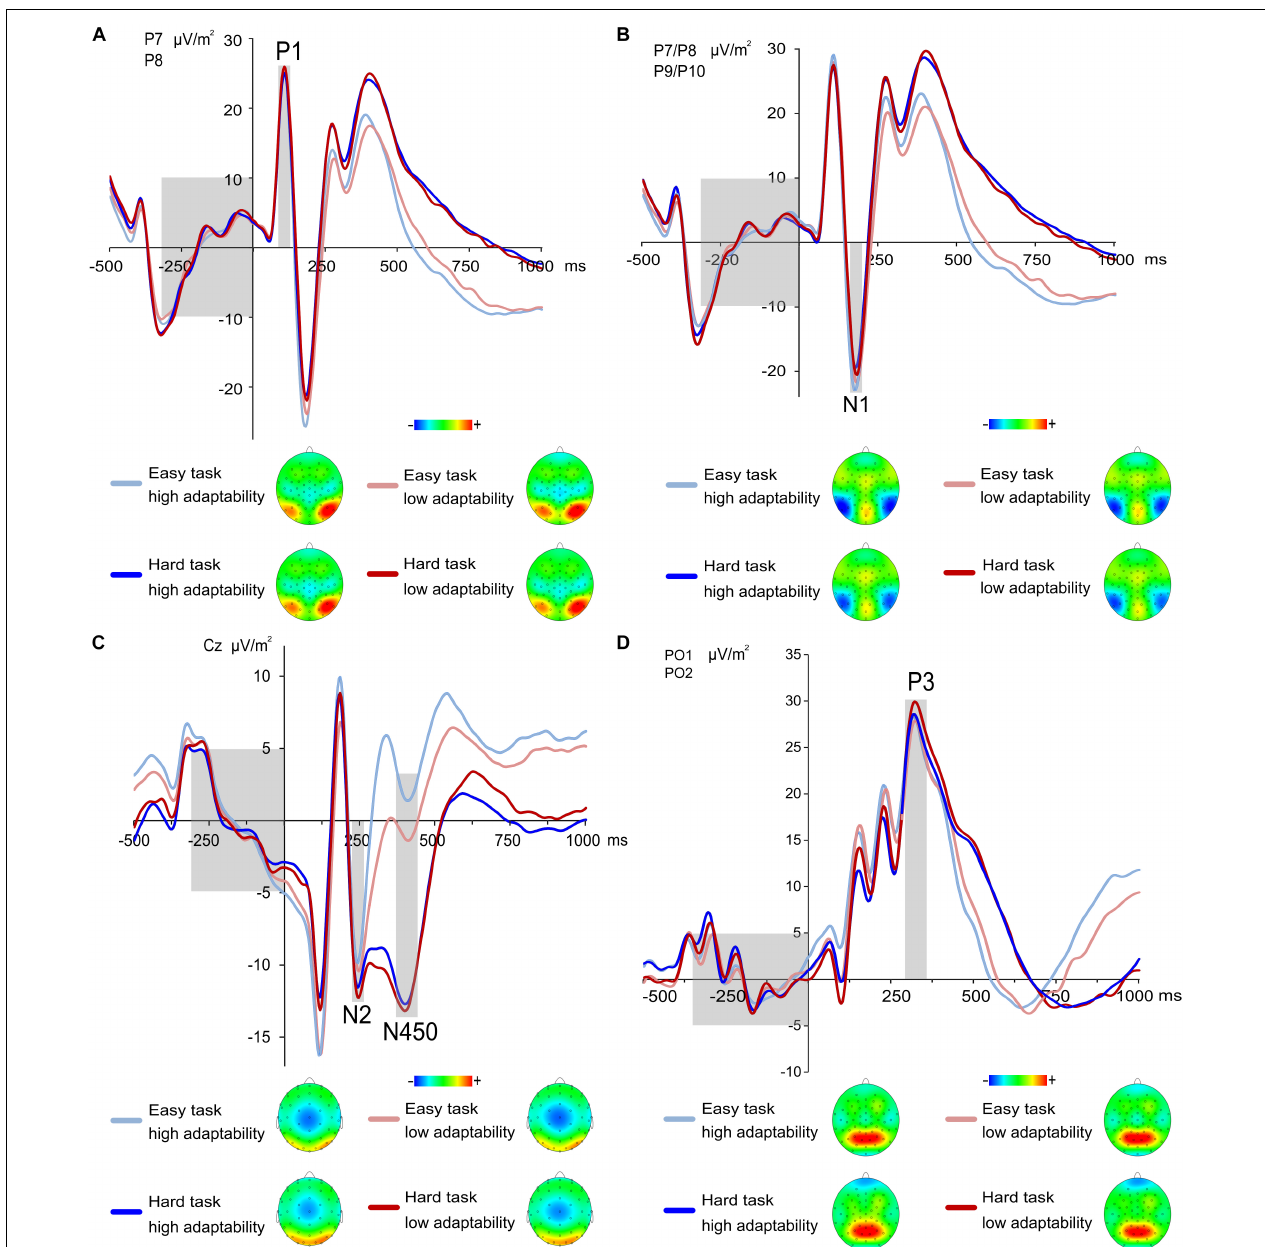
FIGURE 3 | (A) Grand means and topographic plots of the P1 at electrode P7 and P8. Time point zero denotes the time point of the target stimulus onset, the light gray boxes illustrate the ERP baseline from –300 to 0 ms (left) and time range each effect is averaged across (right). ERPs of the low adaptability group are denoted by red color, while ERPs of the high adaptability group are denoted by blue color. The easy task is denoted in a lighter shade of the respective colors than the hard task. For the P1, amplitudes of the hard task were larger compared to easy task. (B) Grand means of the N1 at electrode P7–P10. Time point zero denotes the time point of the target stimulus onset, the light grey boxes illustrate the ERP baseline from –300 to 0 ms (left) and time range each effect is averaged across (right). ERPs of the low adaptability group are denoted by red color, while ERPs of the high adaptability group are denoted by blue color. The easy task is denoted in a lighter shade of the respective colors than the hard task. For the N1, amplitudes of the easy task were larger compared to hard task. (C) Grand means of the stimulus-locked N2 and N450 at electrode Cz. The topographic plots are displayed for the N450, as the main effect of task was only visible in the topographic plots in the N450 time window. Time point zero denotes the time point of the target stimulus onset; the light gray boxes illustrate the ERP baseline from –300 to 0 ms (left) and time range the N2 effect (middle) and N450 effect (right) is averaged across. ERPs of the low adaptability group are denoted by red color, while ERPs of the high adaptability group are denoted by blue color. The easy task is denoted in a lighter shade of the respective colors than the hard task. (D) Grand means and topographic plots of the stimulus-locked P3 at electrode PO1 and PO2. Time point zero denotes the time point of the target stimulus onset, the light gray boxes illustrate the ERP baseline from –300 to 0 ms (left) and time range each effect is averaged across (right). ERPs of the low adaptability group are denoted by red color, while ERPs of the high adaptability group are denoted by blue color. The easy task is denoted in a lighter shade of the respective colors than the hard task.